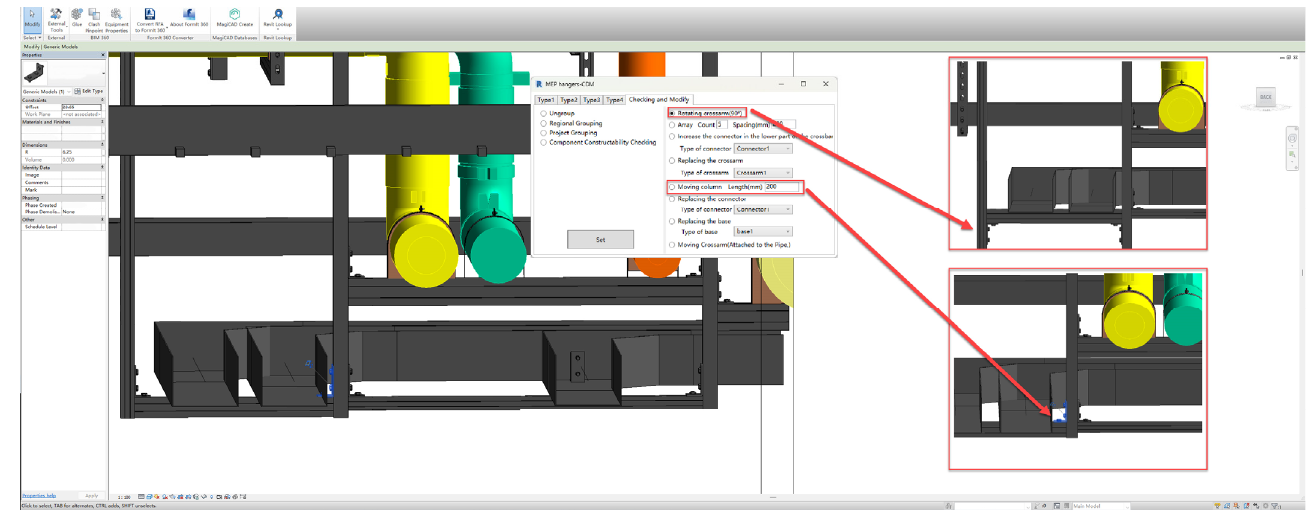
Figure 16. The user interface of the Checking and Modify.